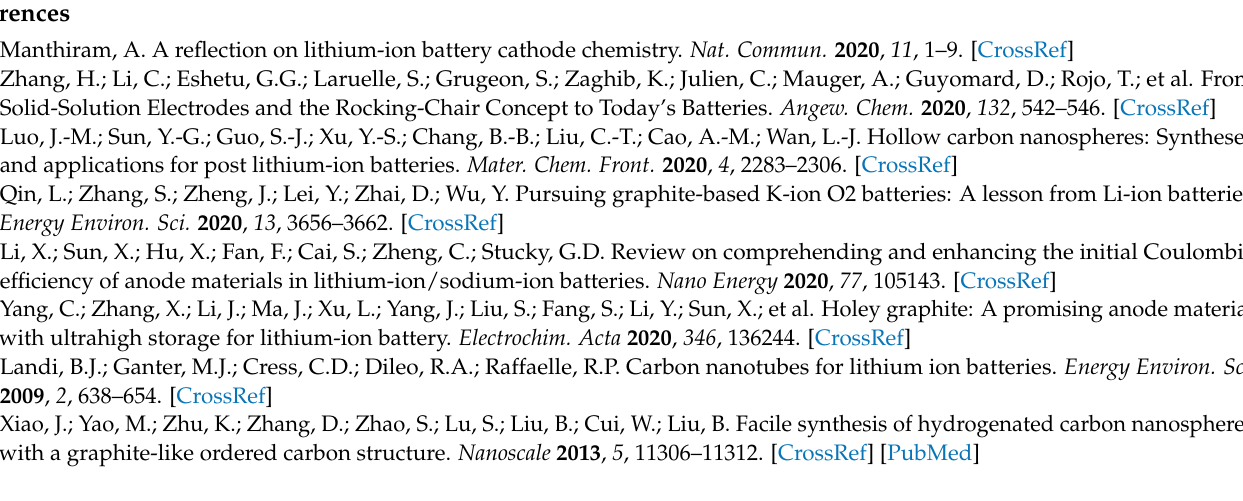
V; Table S1: The various BET surface area data of N-doped carbon materials for LIBs; Table S2: The various cycling performances of N-doped carbon materials for LIBs; Table S3: The fitting parameters for EIS spectra of the NC and HSNC samples in